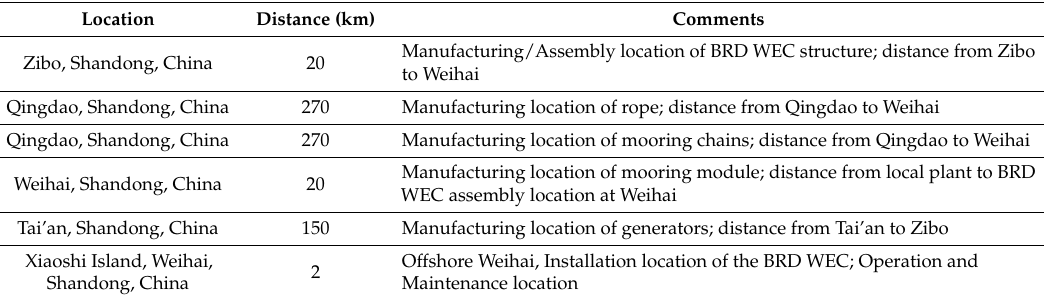
Table 2. Distances taken into account for BRD WEC LCA.